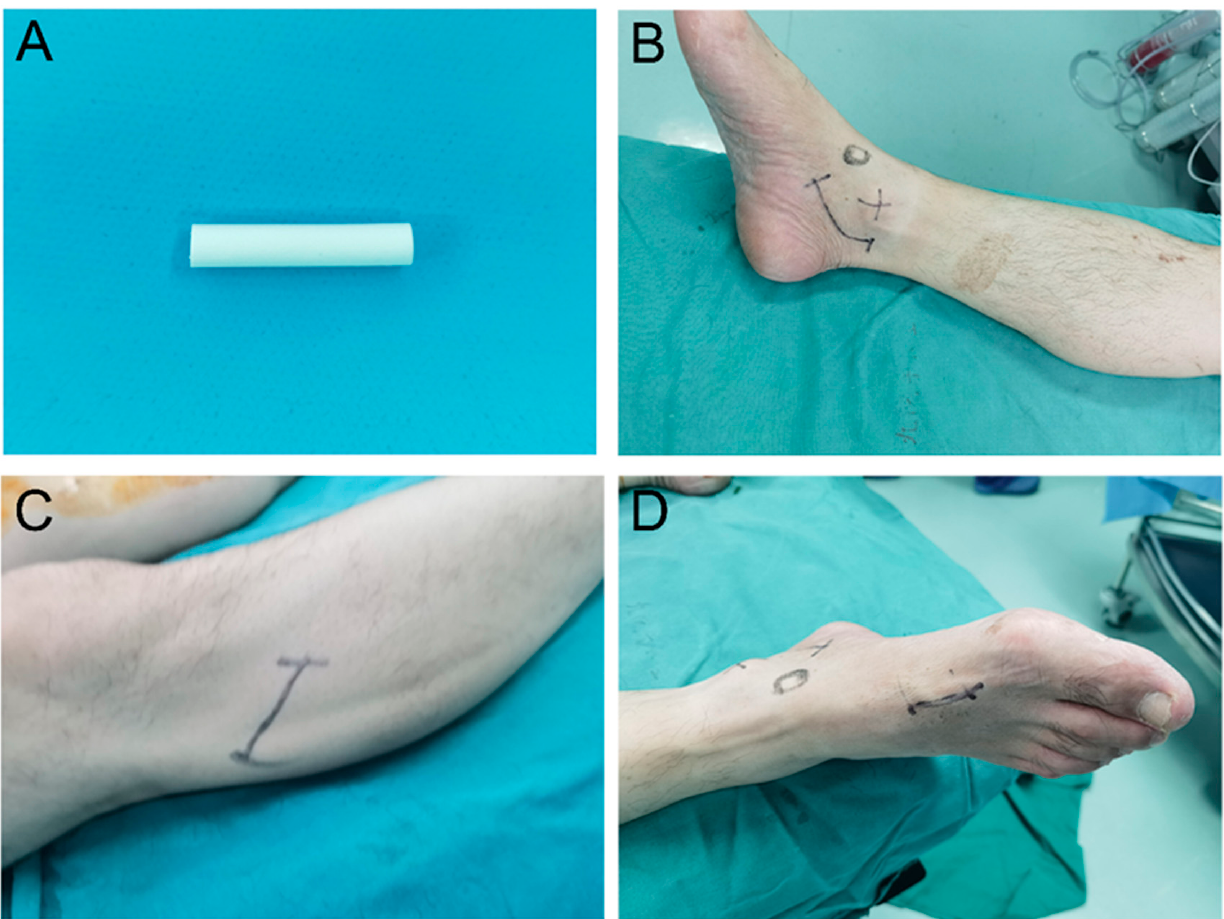
Figure 1. Illustration of the nerve conduit and incisions. ( A ) Photograph of the nerve conduit. ( B ) Pho- tograph of the third surgical incision. ( C ) Photograph of the first surgical incision. ( D ) Photograph of the second surgical